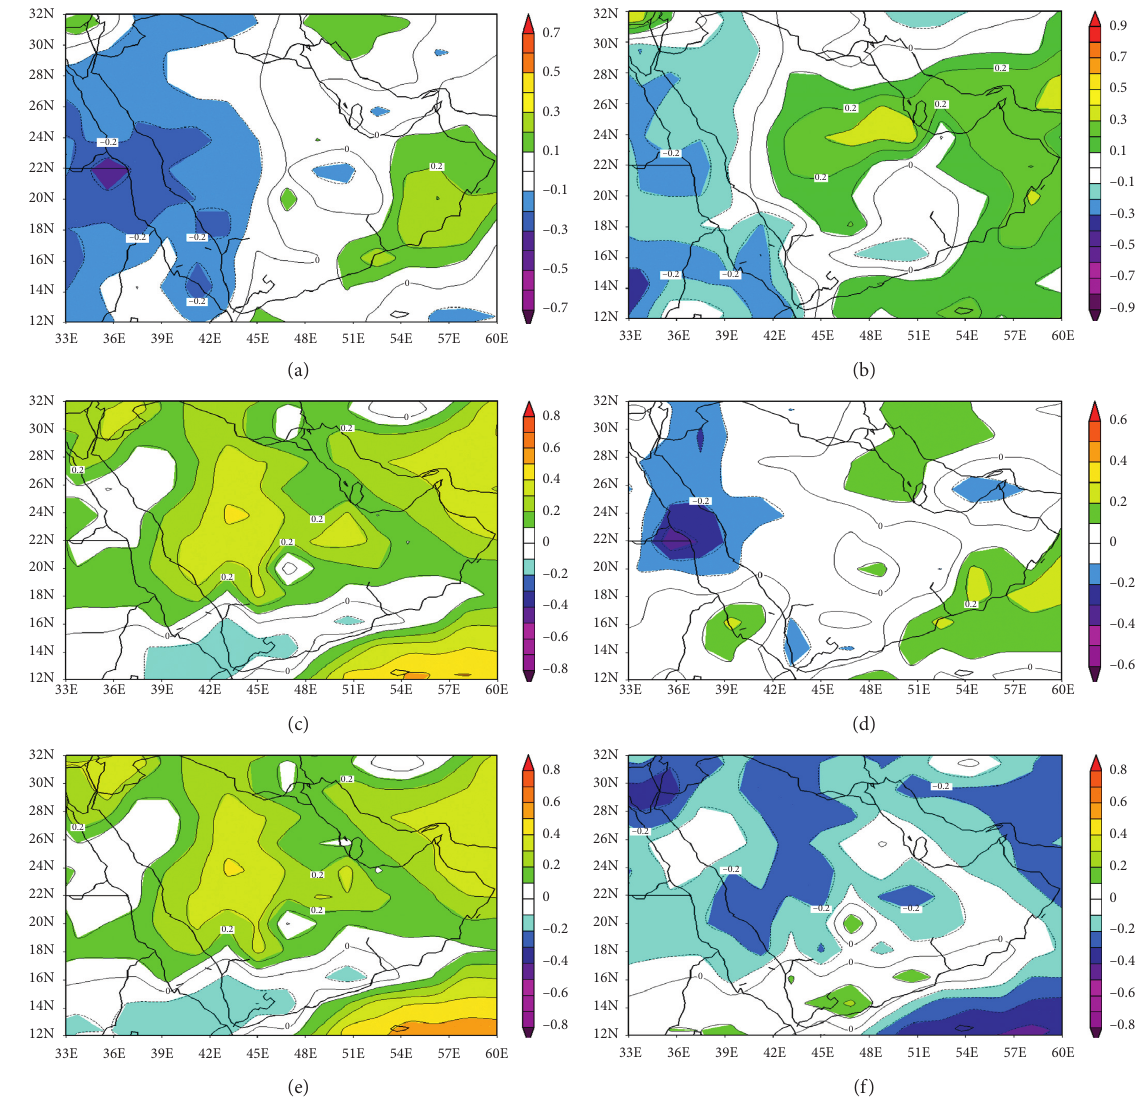
Figure 9: The distribution of the correlation coefficients between the PR over the Arabian Peninsula, including SA, and the climatic indices for the fall season during the study period (1948–2018). (a) AO. (b) GSAT. (c) MEI. (d) NAO. (e) Nino 3.4. (f) SOI (NCEP/NCAR Reanalysis NOAA/ESRL Physical Sciences